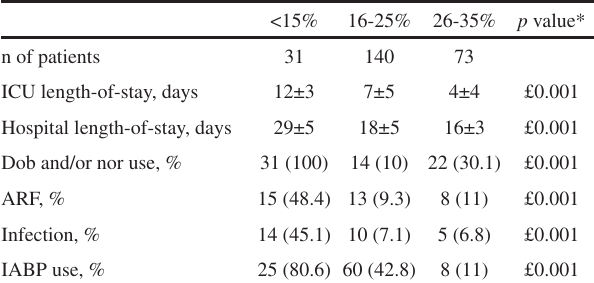
Table 1 - Baseline characteristics